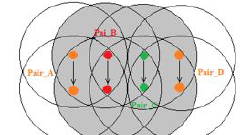
Figure 4: Four pairs scenario (Scenario